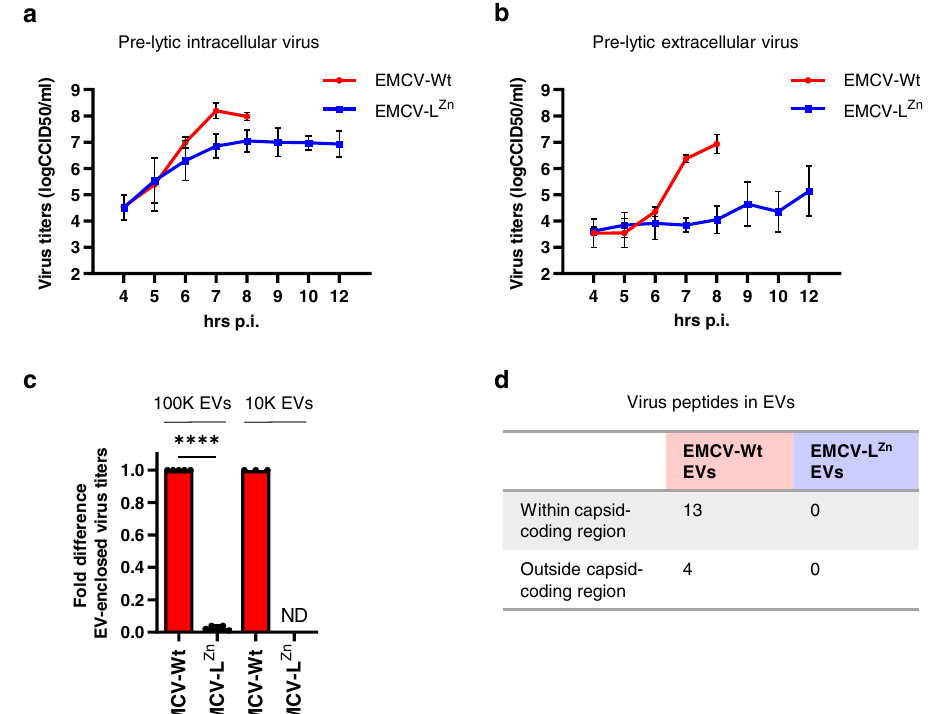
Fig. 1 Inactivation of the Leader protein reduces EV-enclosed virus release by EMCV-infected cells. a , b EMCV-Wt and EMCV-L Zn -infected HeLa cells and corresponding cell culture supernatants were harvested at the indicated timepoints after infection. Line graphs display the increase in intracellular virus titers ( a ) and virus titers in the cell culture supernatant ( b ) over time, as determined by end-point dilution. Depicted are mean values ± SD from n = 3 independent experiments. c 10 K and 100 K EVs were separated from naked virions using density gradient centrifugation and EV-enclosed virus titers were determined by end-point dilution assay. Bars display the mean fold infectivity of EMCV-L Zn EVs relative to EMCV-Wt EVs ± SD from n = 5 independent experiments. **** p < 0.0001, as assessed by a two-tailed one-sample t -test. ND not detected. d 100 K EVs released by cells infected with either EMCV-Wt or EMCV-L Zn were isolated and EV-protein composition was analyzed by LC-MS/MS. The number of unique EMCV peptides identi fi ed within and outside of the capsid-coding region are indicated. Source data are provided as a Source Data fi